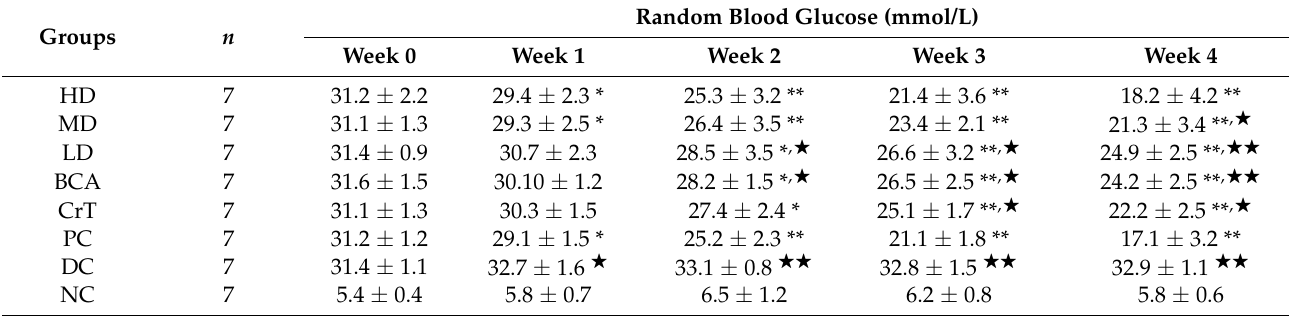
Table 4. Changes in random blood glucose level.